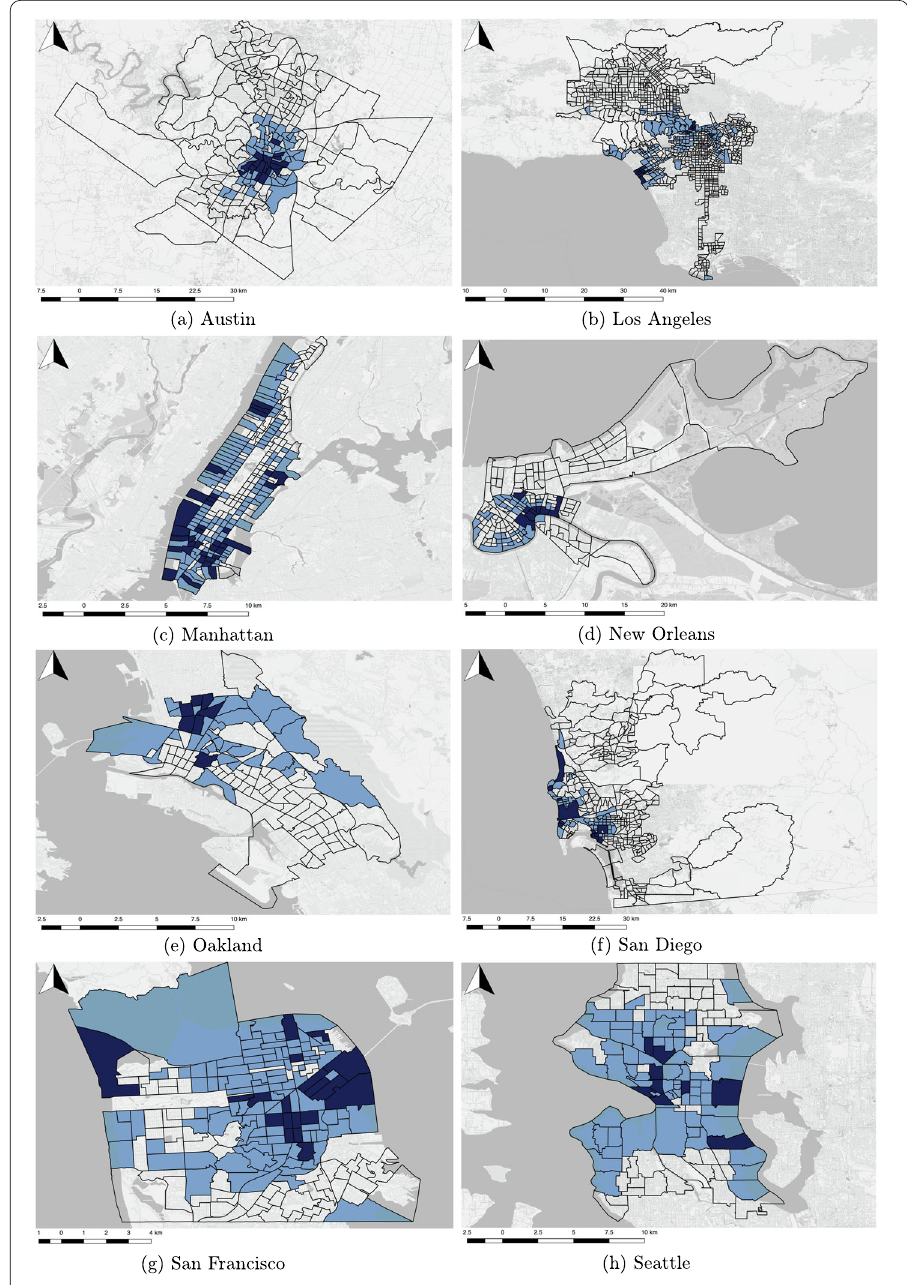
Figure 2 Choropleth Map of Airbnb penetration according the three produced bins: ‘low’ (transparent background), ‘medium’ (cyan background), and ‘high’ Airbnb penetration (dark blue background)